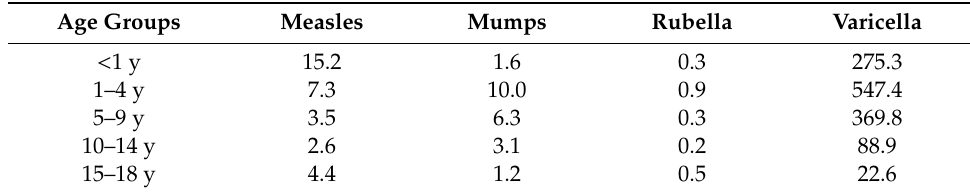
Table 2. Measles, mumps, rubella and varicella incidences per 100,000 population per year according to age-groups (2009–2018) [19].